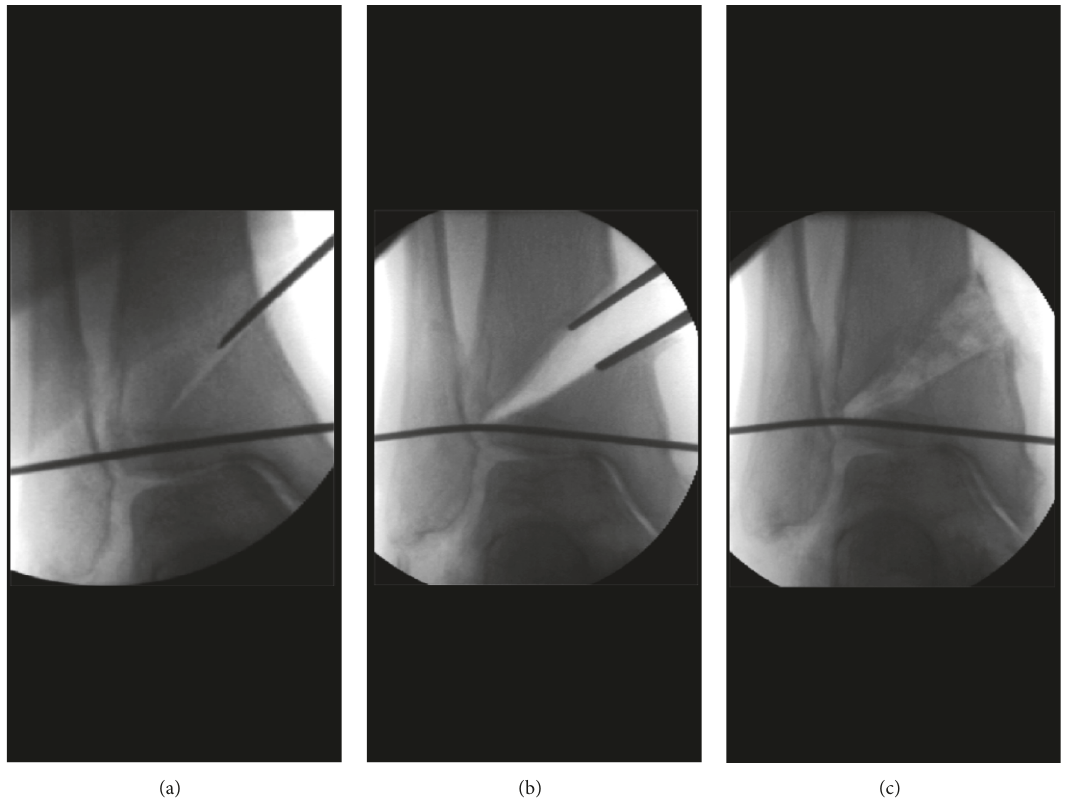
Figure 10: Distal tibial oblique osteotomy